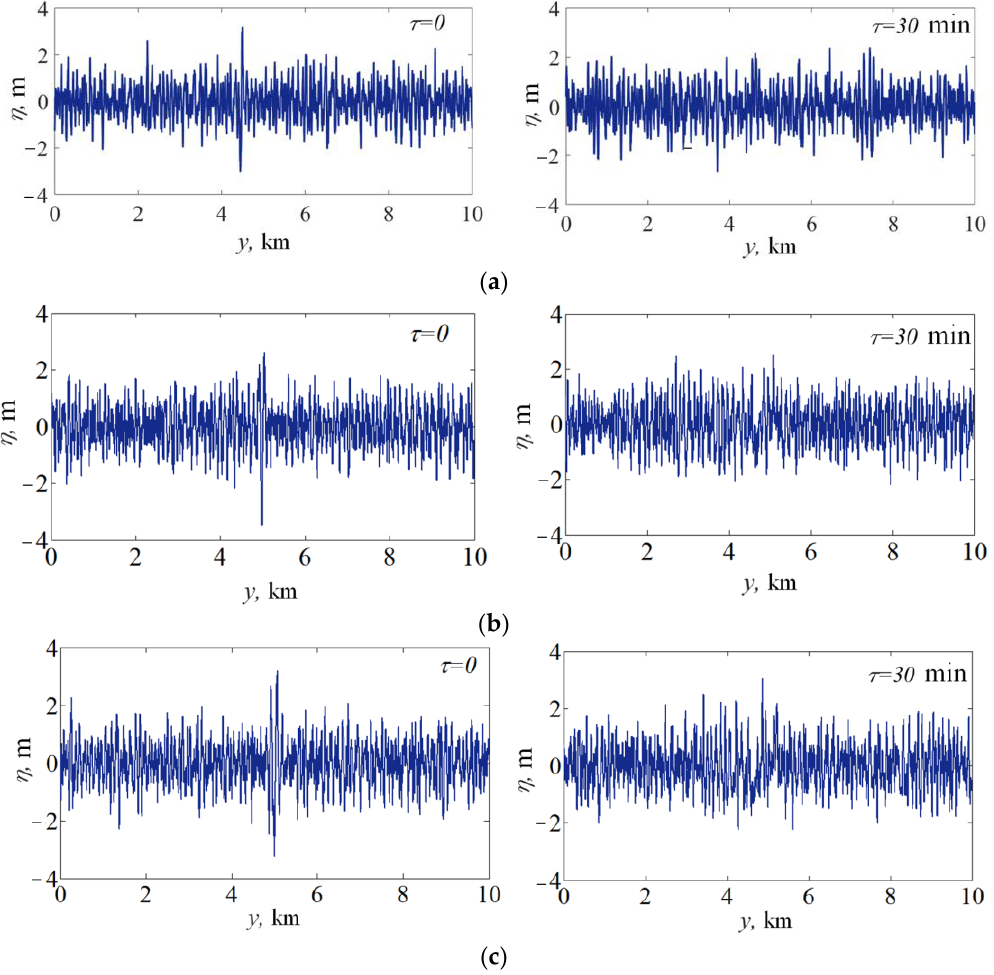
Figure 10. Evolution of freak waves in the wind wave field: ( a ) sign-variable wave; ( b ) “two sisters”; and ( c ) “three sisters”.